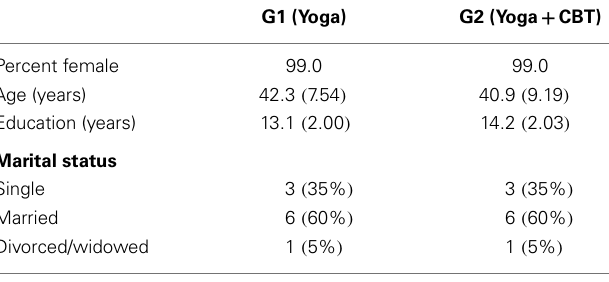
Table 1 | Demographic characteristics of G1 and G2 subjects